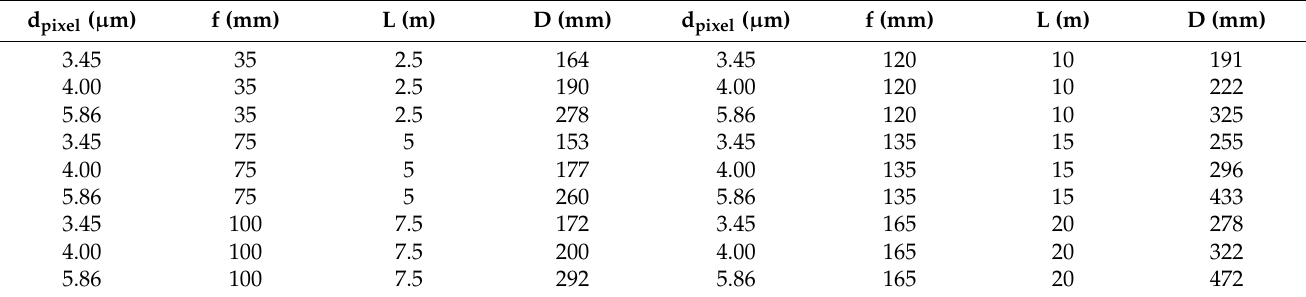
Table 2. Recommended parameter